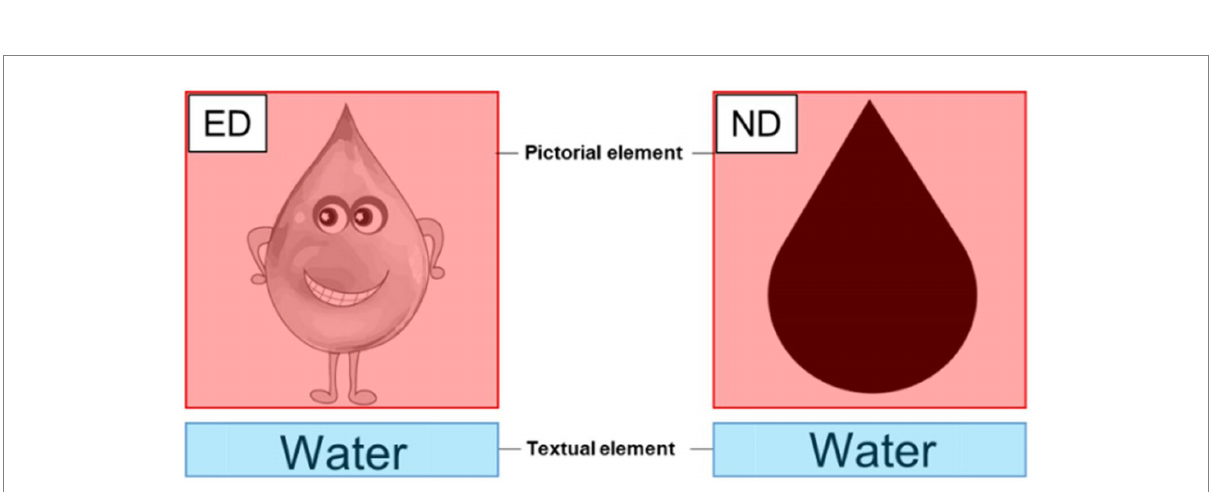
FIGURE 4 Sample presentation of areas of interest (AOIs) for the stimulus water (translated from German) in the emotional design (ED) and the neutral design (ND). Red: AOI pictorial ; blue: AOI textual